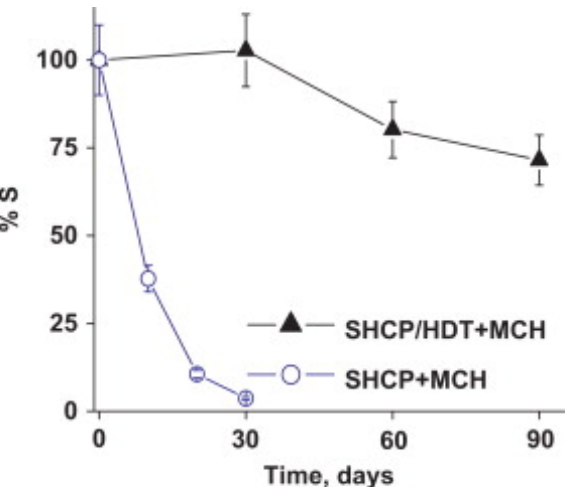
Figure 2. Stability of DNA biointerfaces atop binary and ternary self-assembled monolayers (SAMs), as measured by % retention of the original current response. Reprinted with permission from Ref. [54]. Copyright 2012 Elsevier